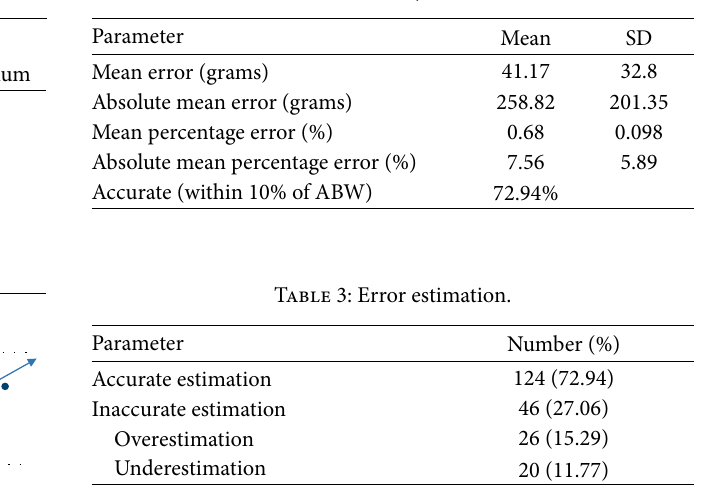
Table 2: Accuracy of method.